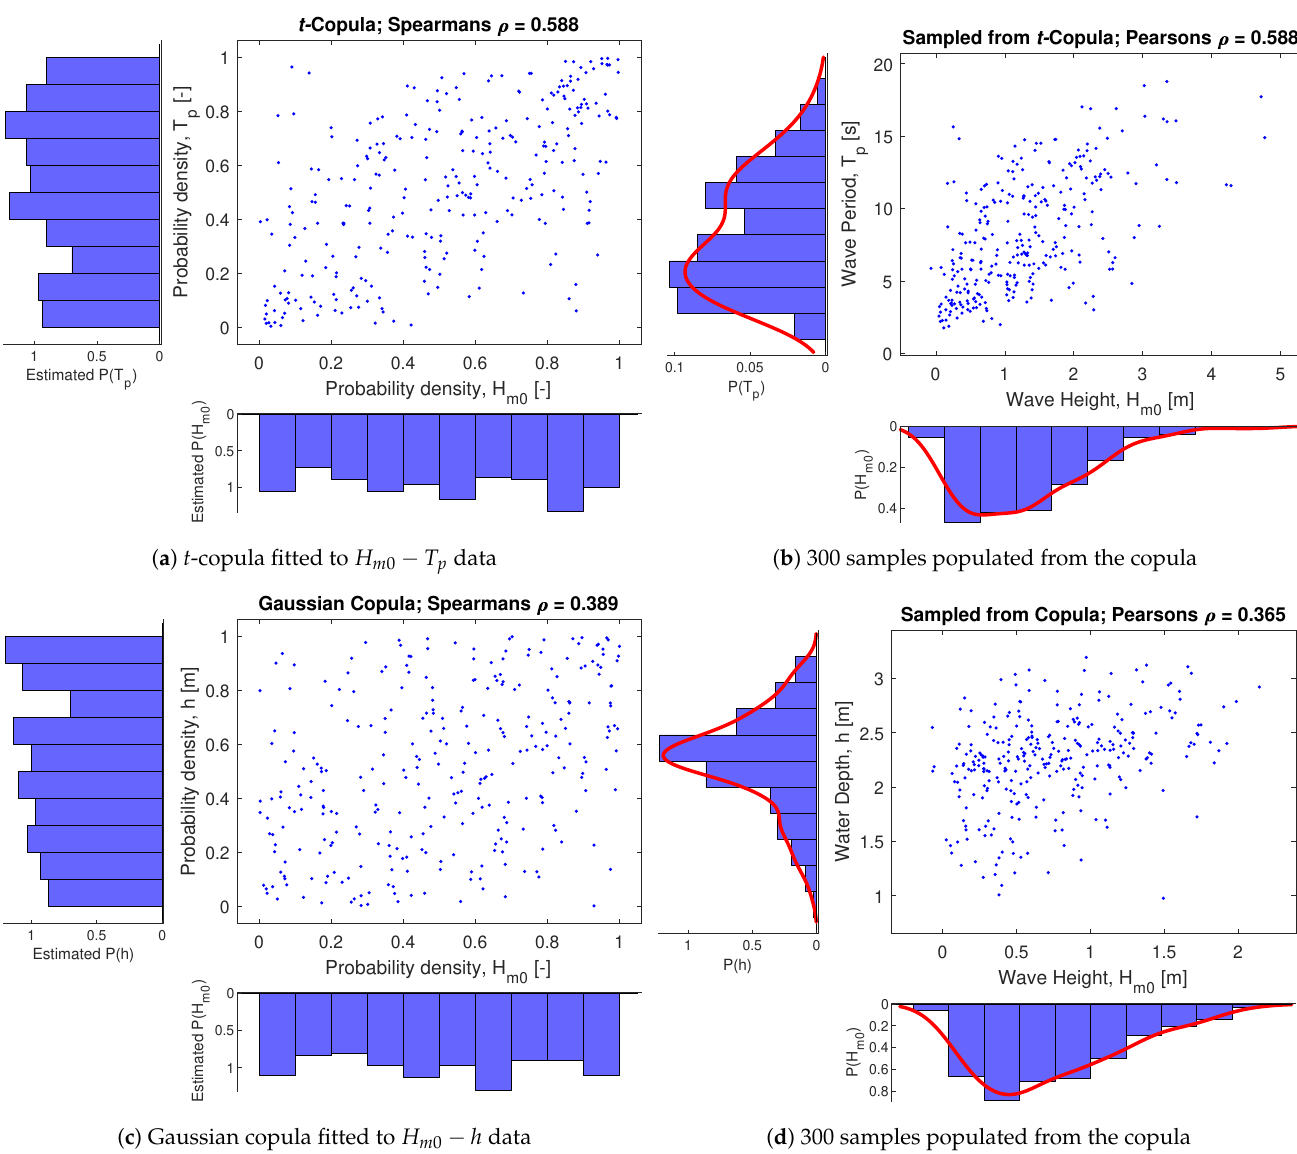
Figure 7. Copulas and correlations determined from data for hydrodynamic variables ( H m 0 , T p , h ) . The resulting ranges, distributions, and correlations from literature meta-analysis, data processing, and expert judgment are presented in Tables 2 and 4 along with their main source. These quantification results formed the basis for setting up the nonparametric Bayesian networks for salt marshes and mangroves as presented in Figure 8 and Figure 9